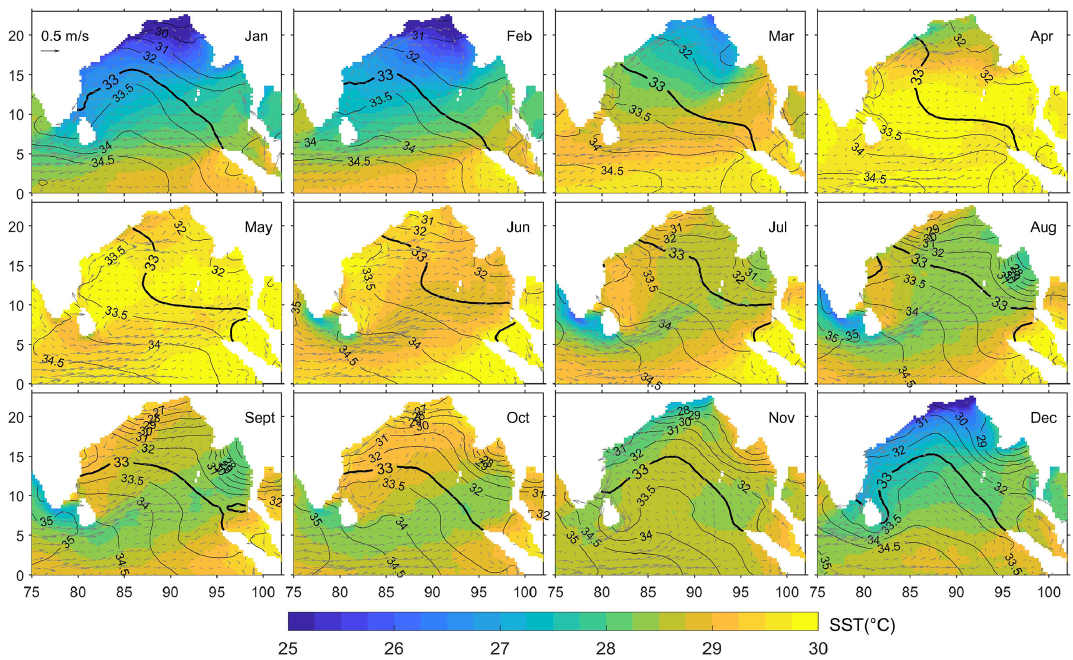
Figure 1. Climatological monthly sea surface temperature fields (color), mean surface currents (arrows), and surface salinity (contours) in the Bay of Bengal. The climatological sea surface temperature fields are from the monthly averaged OISST dataset with a 0.25 ◦ regular grid at global scale from January 1982 to December 2011 (Banzon et al., 2014; ftp://eclipse.ncdc.noaa.gov/pub/OI-daily-v2/, last access: 8 April 2022). The climatological surface currents are from the monthly averaged global total velocity field (MULTI- OBS_GLO_PHY_REP_015_004) at 0 and 15m with a 0.25 ◦ grid from January 1993 to December 2018 (Etienne, 2018). The climatological surface salinity fields are from the global SSS/SSD L4 reprocessed dataset (MULTIOBS_GLO_PHY_REP_015_002) with a 0.25 ◦ grid from January 1993 to December 2018 (Mertz et al., 2018). The latter two datasets are available at http://marine.copernicus.eu (last access: 12 August